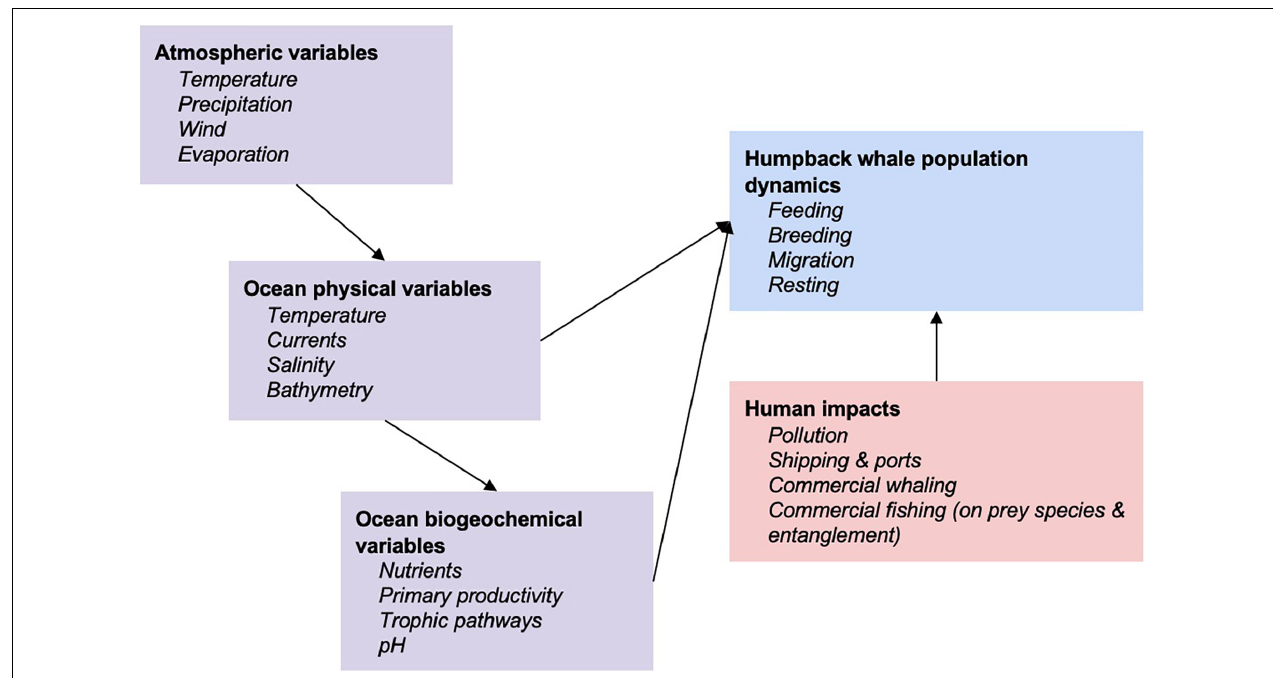
FIGURE 1 | Conceptual framework to a systems approach of understanding humpback whale responses to environmental variables and human impacts (adapted from Meynecke et al.,